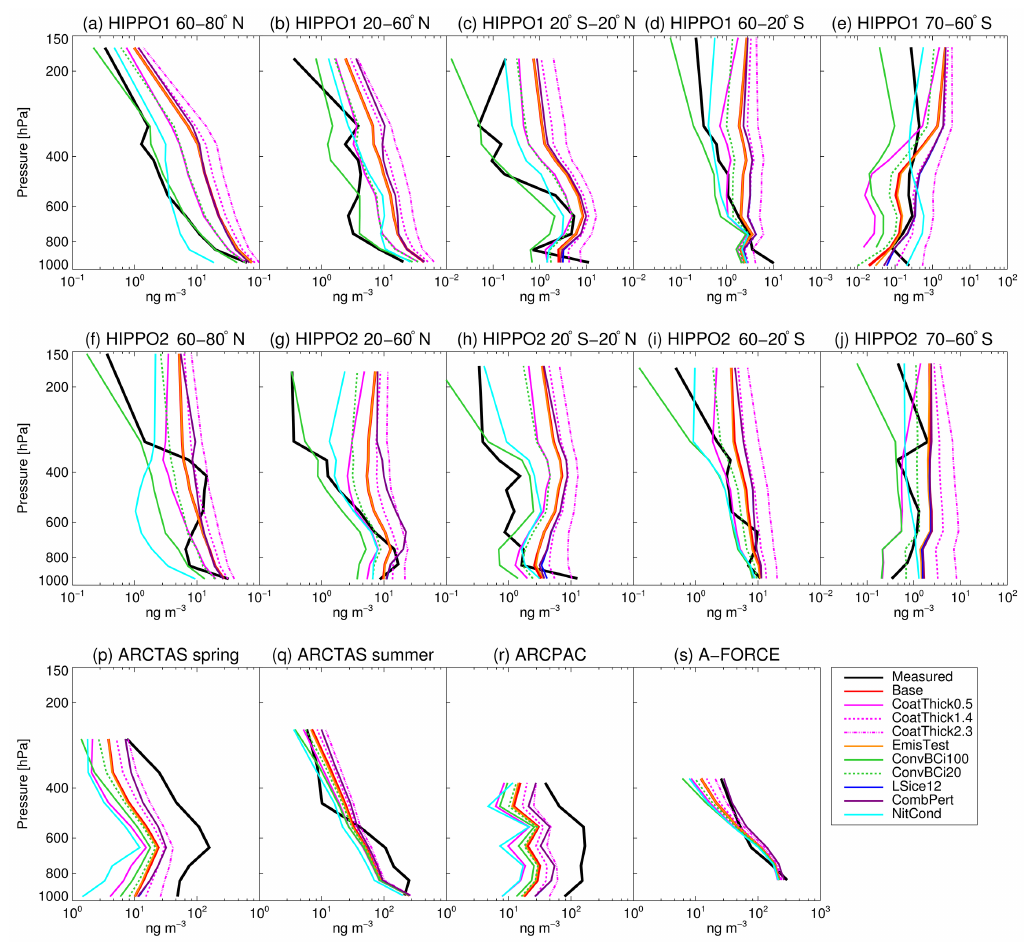
Figure 5. Vertical BC profiles in the baseline and sensitivity experiments compared to flight